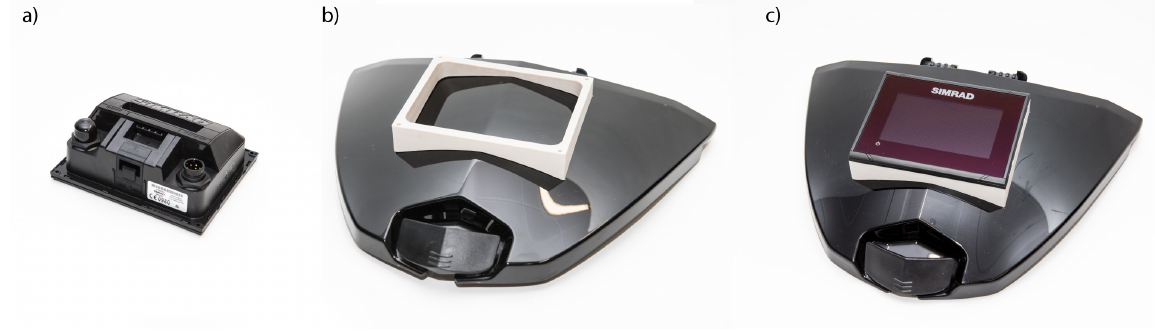
Figure 6: The underside of the chart-plotter unit that is to be mounted (a). The adapter component had to match the flat underside of the plotter flange to the curved surface of the fairing (b). The completed assembly (c).